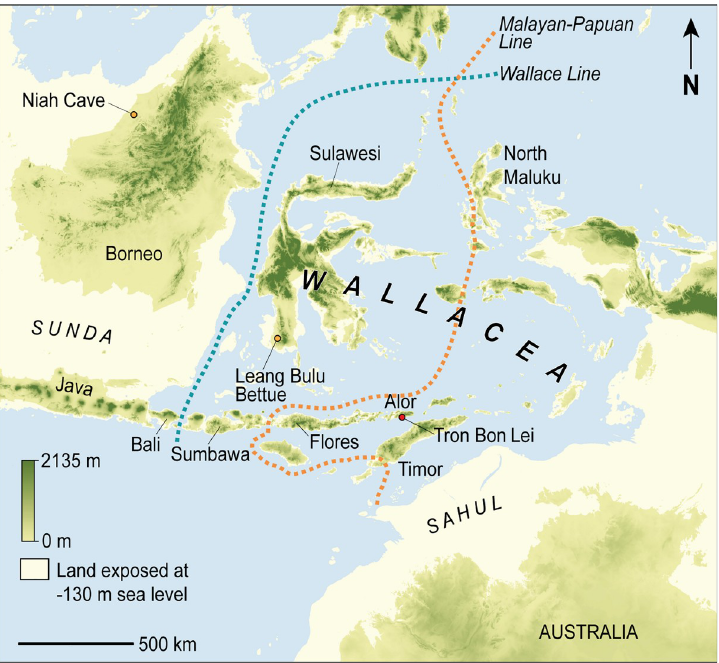
Fig 1. Map of Wallacea showing the location of Sulawesi. The Late Pleistocene cave site Leang Bulu Bettue is located in the island’s southwestern peninsula, known as South Sulawesi. Wallacea comprises an extensive zone of oceanic islands located east of a significant biogeographical boundary, the Wallace Line. This archipelago is positioned between the continental regions of Asia (Sunda) and Australia-New Guinea (Sahul). The Malayan-Papuan Line delineates a major east-west division in the genetic diversity of modern human populations in Wallacea. Map source, Shuttle Radar Topography Mission 1 Arc-Second Global by NASA/NGS/USGS; GEBCO_2014 Grid, version 20150318 (http://gebco. net). Base map generated using ArcGIS by M. Kottermair and A.